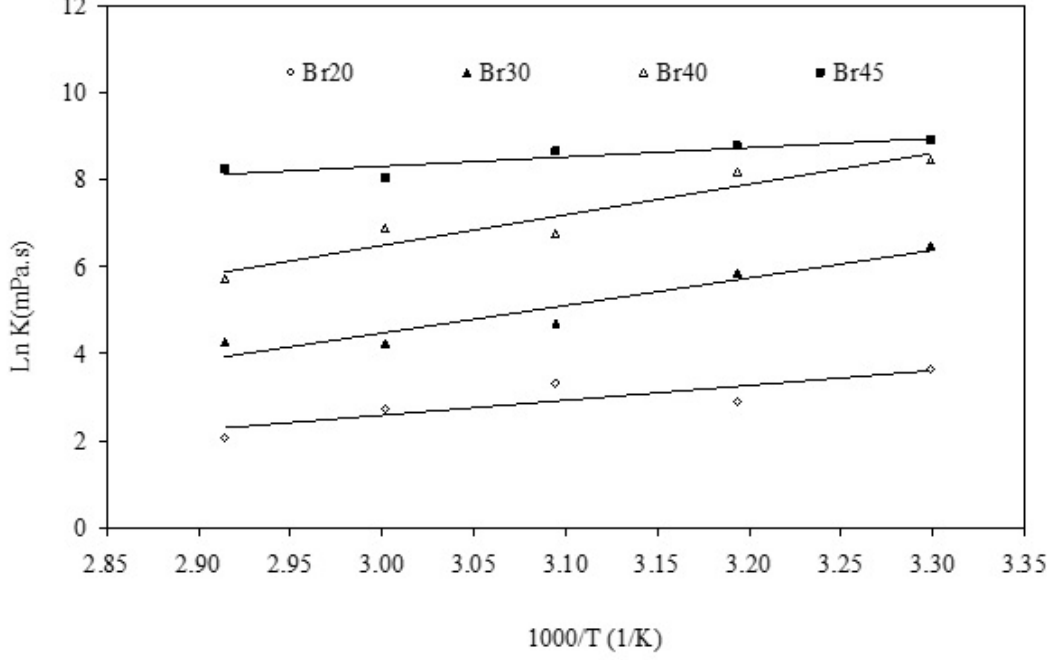
Figure 3. Ln K versus 1/temperature for licorice extract samples with various °Brix (Br).